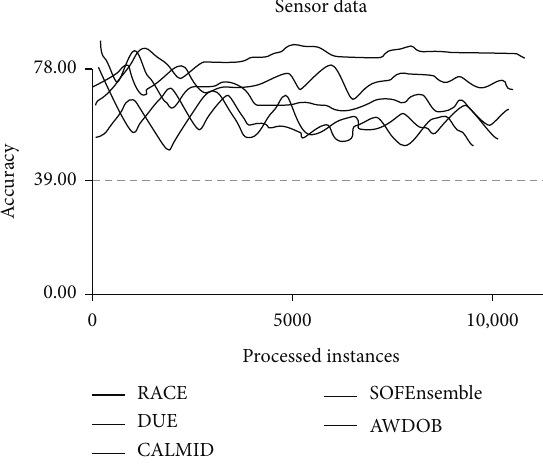
Figure 11: Prediction accuracy of the five algorithms on the Sensor Data.